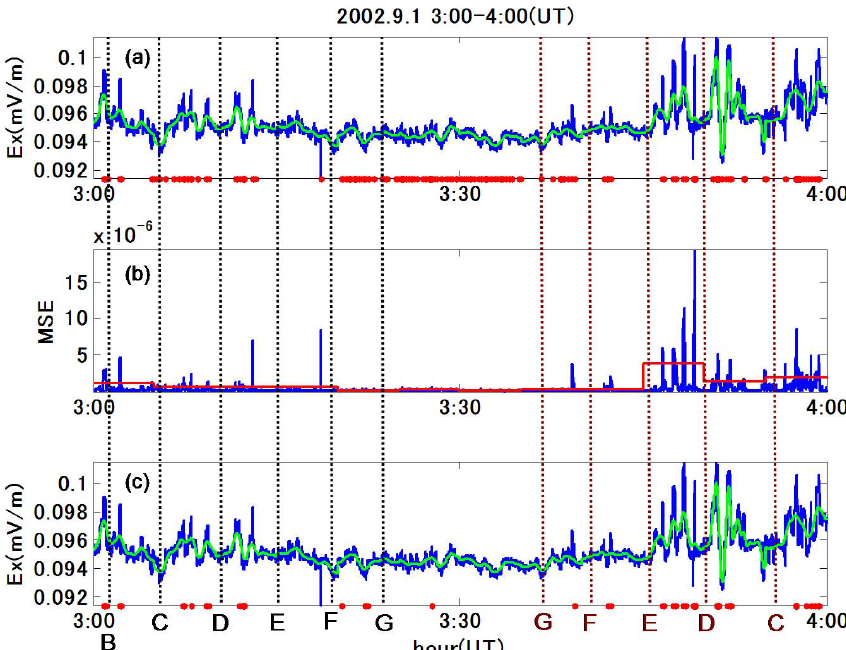
Fig. 21. An example of the DC-driven train noise detection in Ex component with a single station and multiple station data. The analyzed period is 03:00–04:00, on 1 September 2002(UT). (a) The observed data and the reconstructed data using SSA decomposed components with high correlation values at KYS station. Red dots indicate candidates of train noise using a single station threshold. (b) MSE and the threshold values at KYS. (c) The observed data and the reconstructed data using SSA decomposed components with high correlation values at KYS station. Red dots show candidates of train noise using a multiple station threshold.